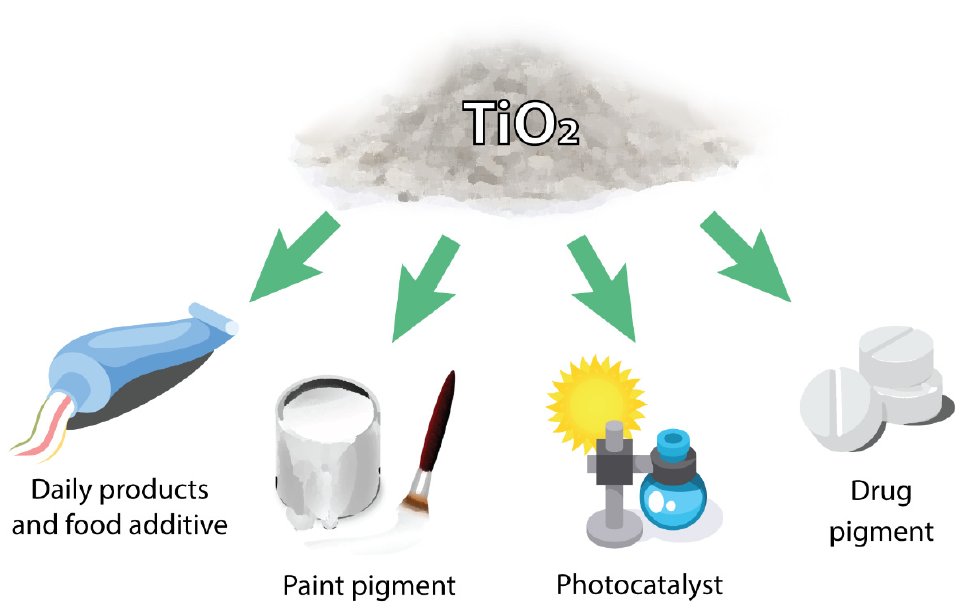
Figure 4. Titanium(IV) oxide and its broad applications.